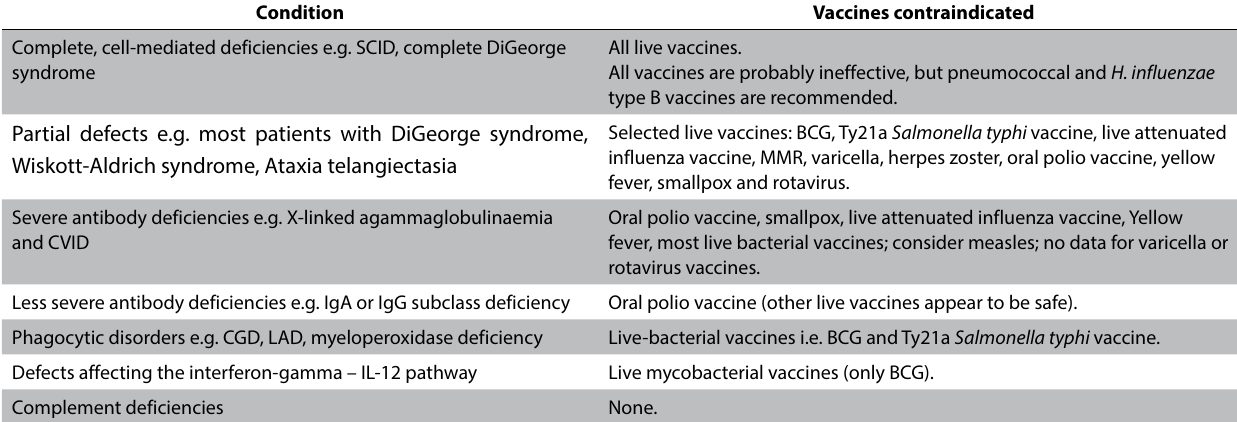
Table II. Immunisations contraindicated in certain PIDs Condition Vaccines contraindicated Complete, cell-mediated deficiencies e.g. SCID, complete DiGeorge